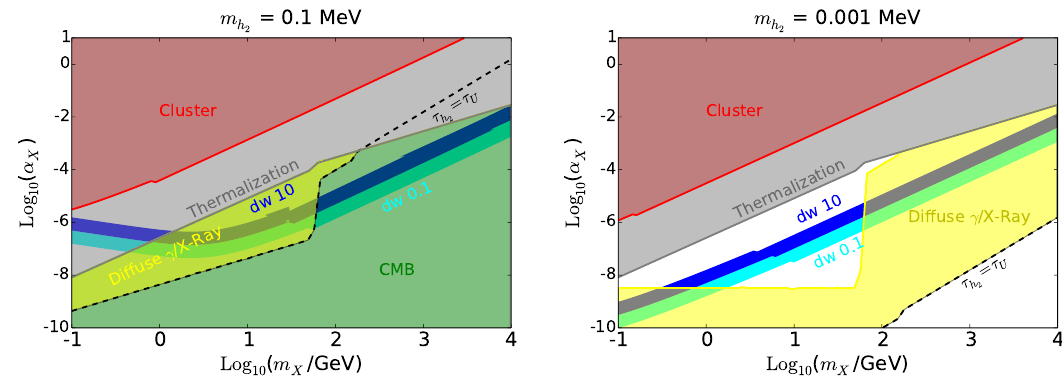
Figure 8 . Same as in (cid:12)gure 7 but for Region (ii) with m h 10 (cid:0) 3 MeV (right panel). When the lifetime of h 2 is longer than the current age of the Universe 10 17 s (denoted by the dashed black curve), we also include the constraints from the (cid:28) U = 4 : 3 (cid:2) di(cid:11)use (cid:13) / X -ray